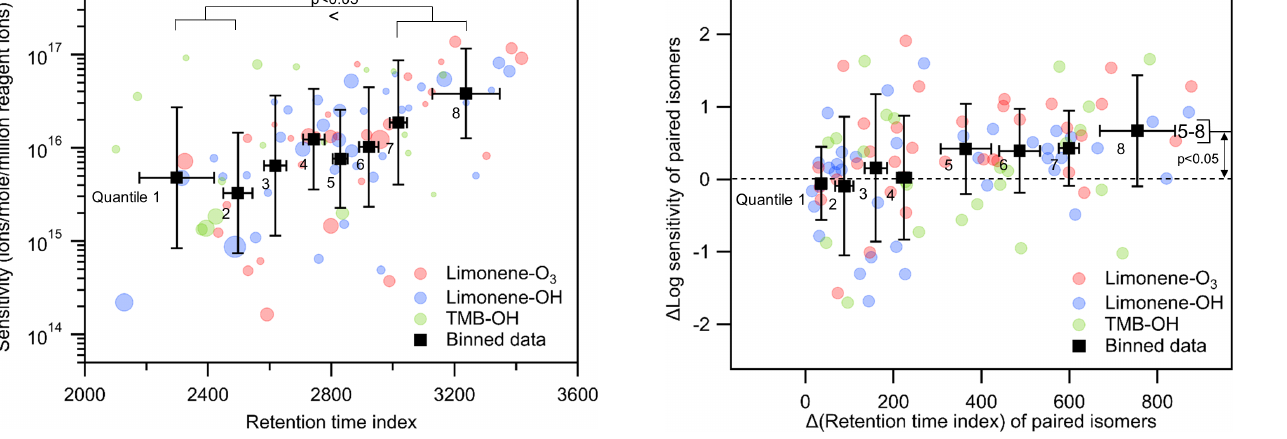
Figure 8. The relationship between differences ( (cid:49) ) in log(sensitivity) and retention index for all pairs of isomers with a given formula. Black markers are all data equally divided into eight bins (octiles) centered on averages with error bars representing standard